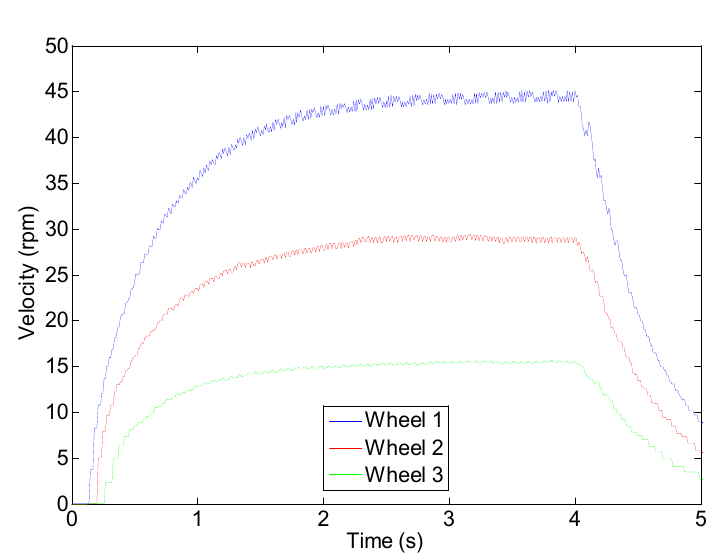
Figure 21. Wheel velocity profile during a closed loop operation.